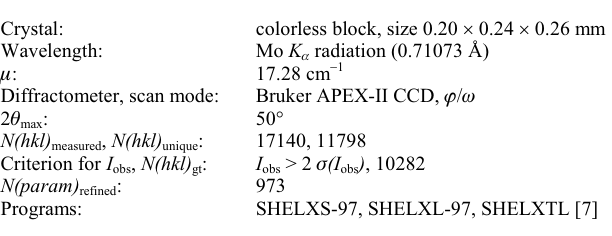
Table 1. Data collection and